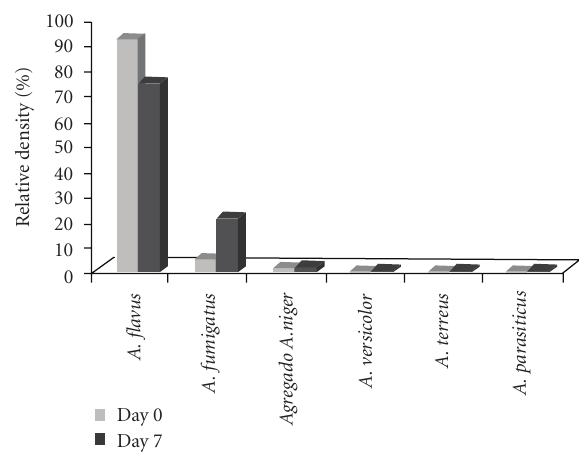
Figure 3: Relative density (%) of Aspergillus species isolated from brewer’s grain at days 0 and 7 of storage destined to pig production.